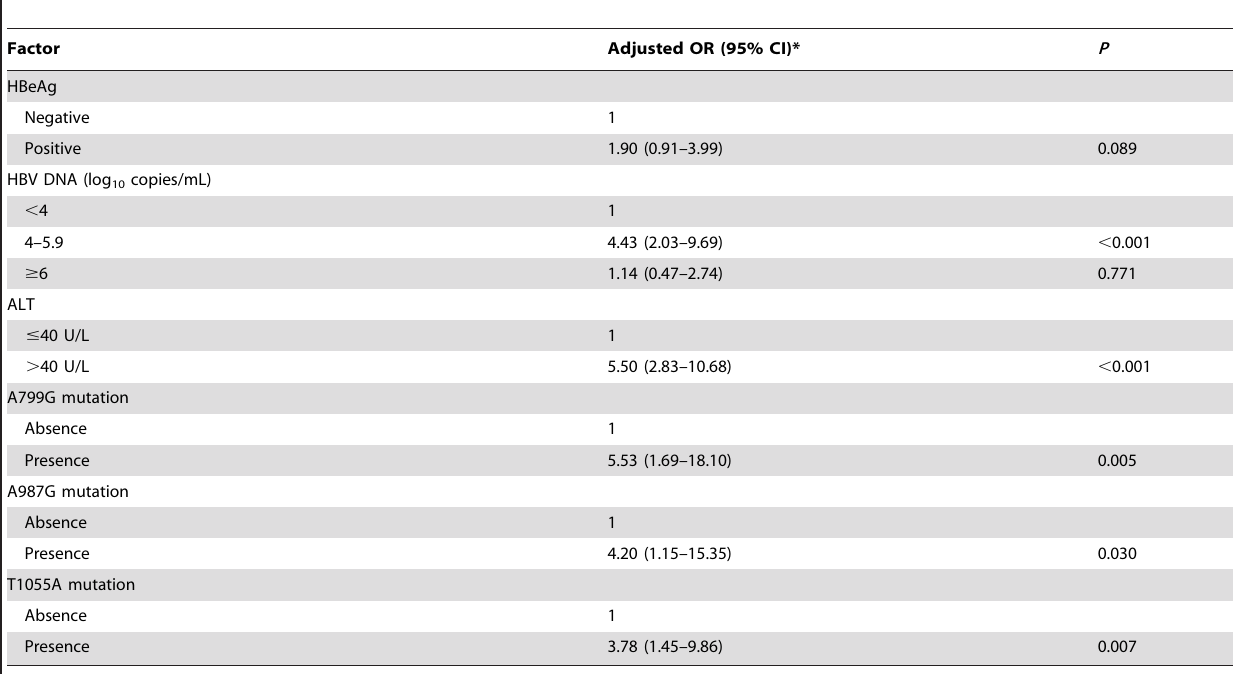
Table 4. Multivariate analysis of risk factors for hepatocellular carcinoma in all patients (n=468).